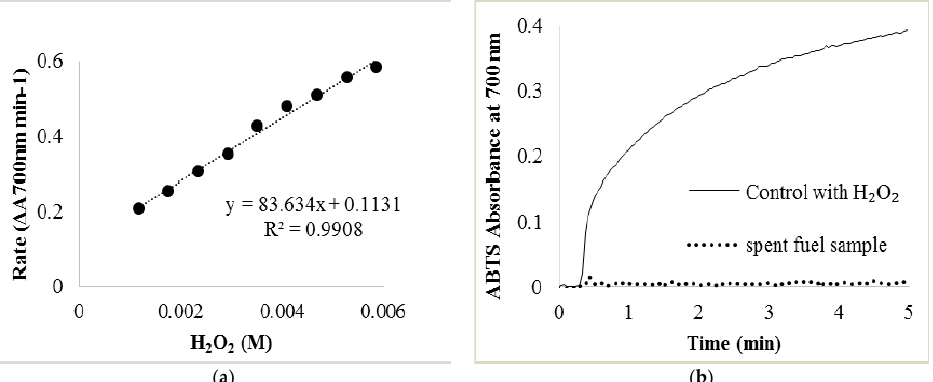
Figure A1. ( a ) Standard curve created by plotting the voltage change of varying concentrations of glycerol in 8 M KOH at 1 mA; ( b ) Polarization curve of a diluted crude glycerol sample from which the labeled voltage was used to determine the concentration of crude glycerol according to the equation expressed in ( a ).